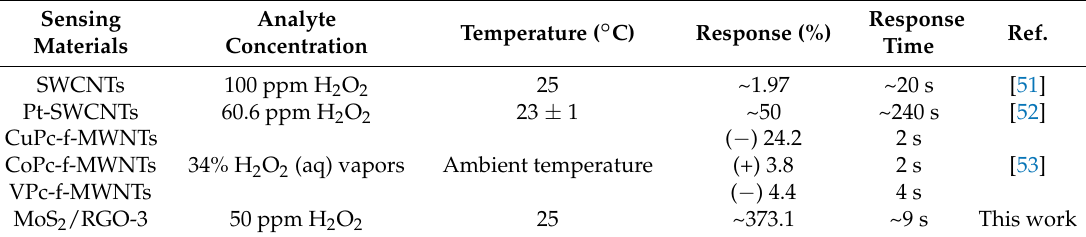
Table 1. Comparison of the reported H 2 O 2 sensors and our sensors of MoS 2 /RGO-3.